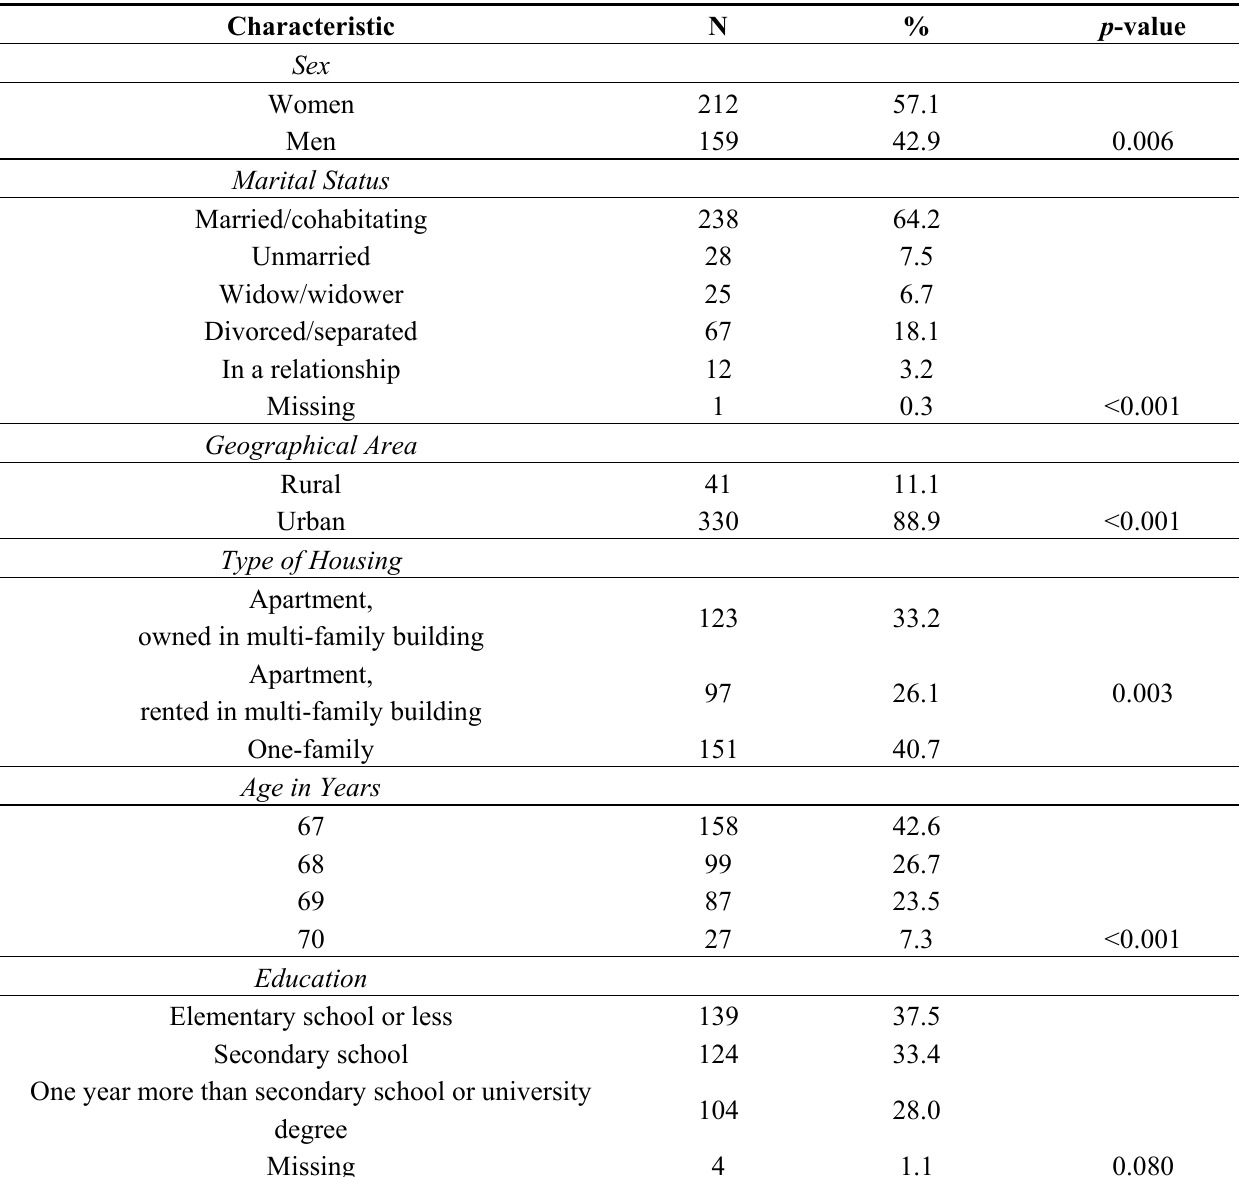
Table 2. Sample characteristics, N =